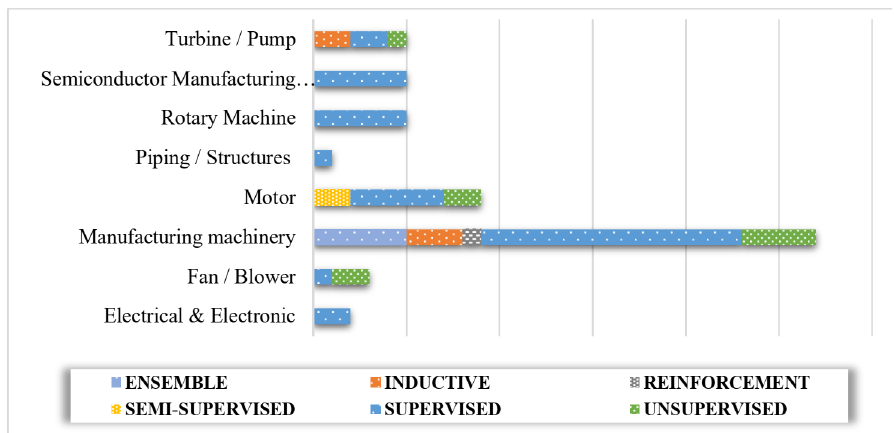
Figure 17. Types of machine learning approaches used for each type of investigated equipment.